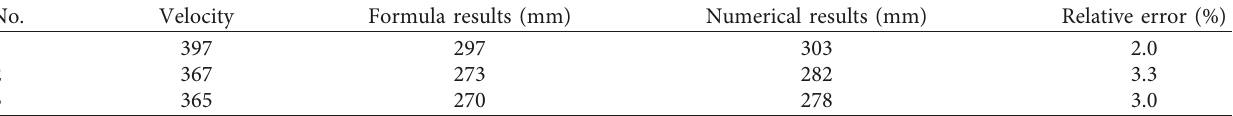
Table 11: Comparisons of formula and numerical simulations on penetration depths of RPC targets. No.